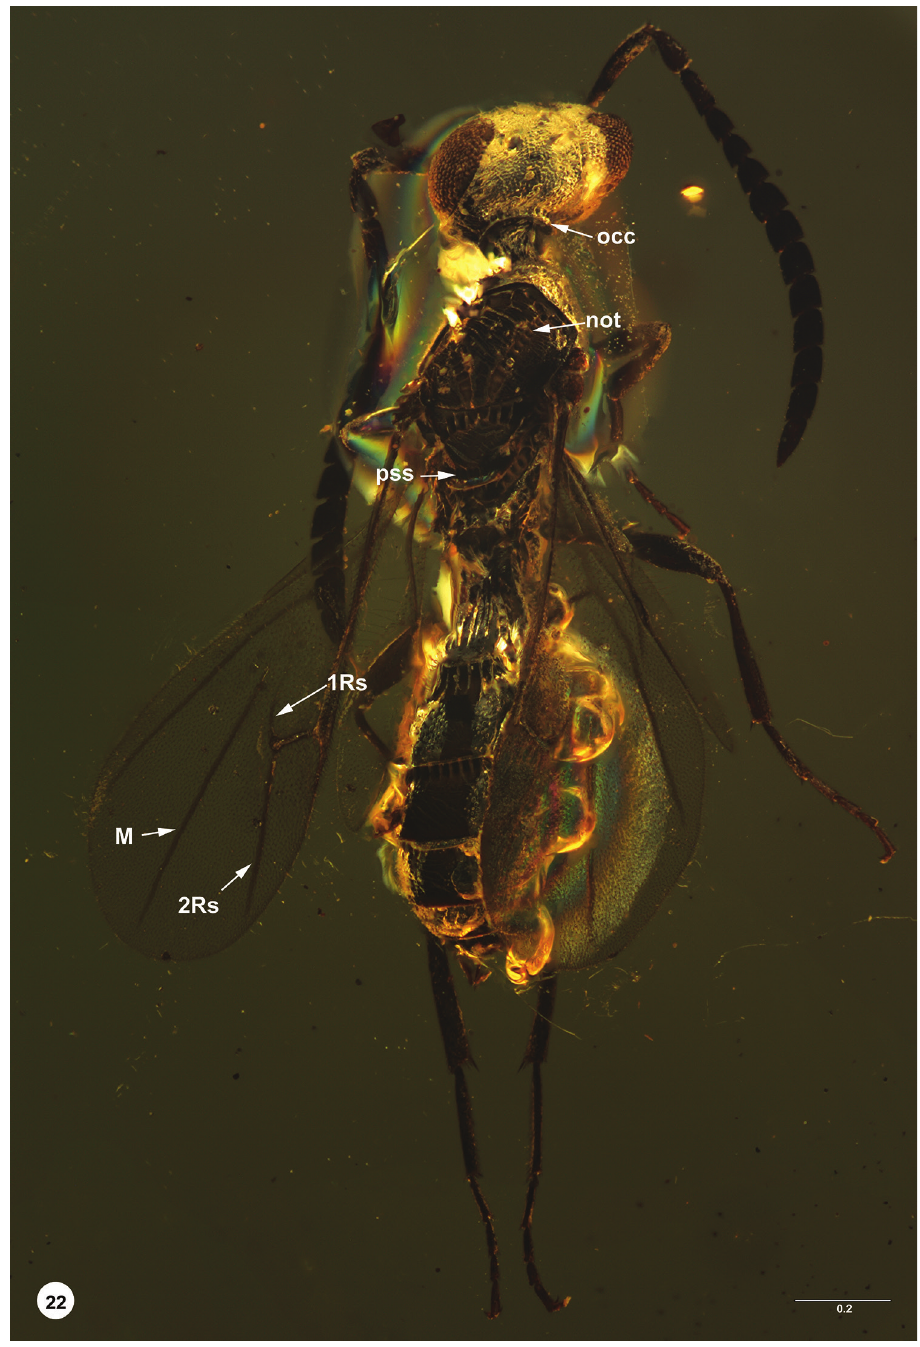
Figure 22. Proteroscelio nexus , female holotype (USNMENT01197245) habitus, dorsal. Scale bar in